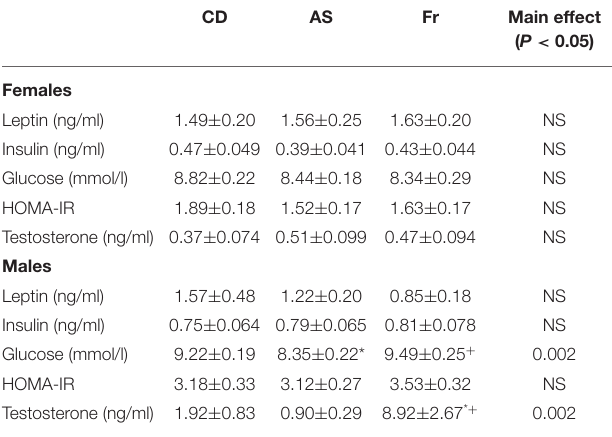
TABLE 2 | Plasma biochemical analysis in female and male